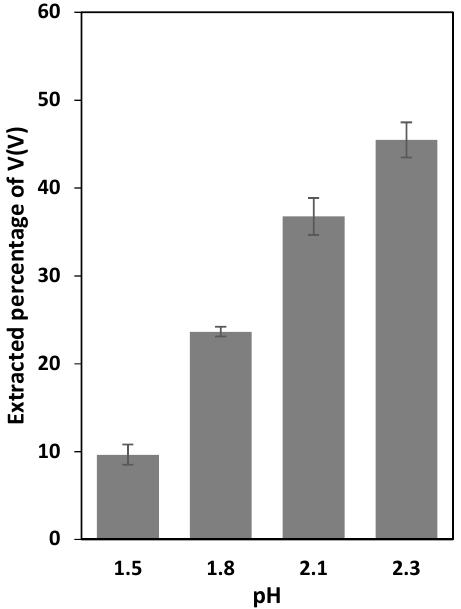
Figure 2. Effect of the aqueous source solution pH on the extraction of V(V) (initial concentration 50 mg L −1 ) from 0.2 mol L −1 sulfate solutions into PVDF-HFP-based PIMs containing 30 wt% Aliquat ® 336. PIMs/aqueous source solution contact time and temperature were 8 h and 22 ± 1 °C, respectively. Error bars = ±standard deviation (SD).